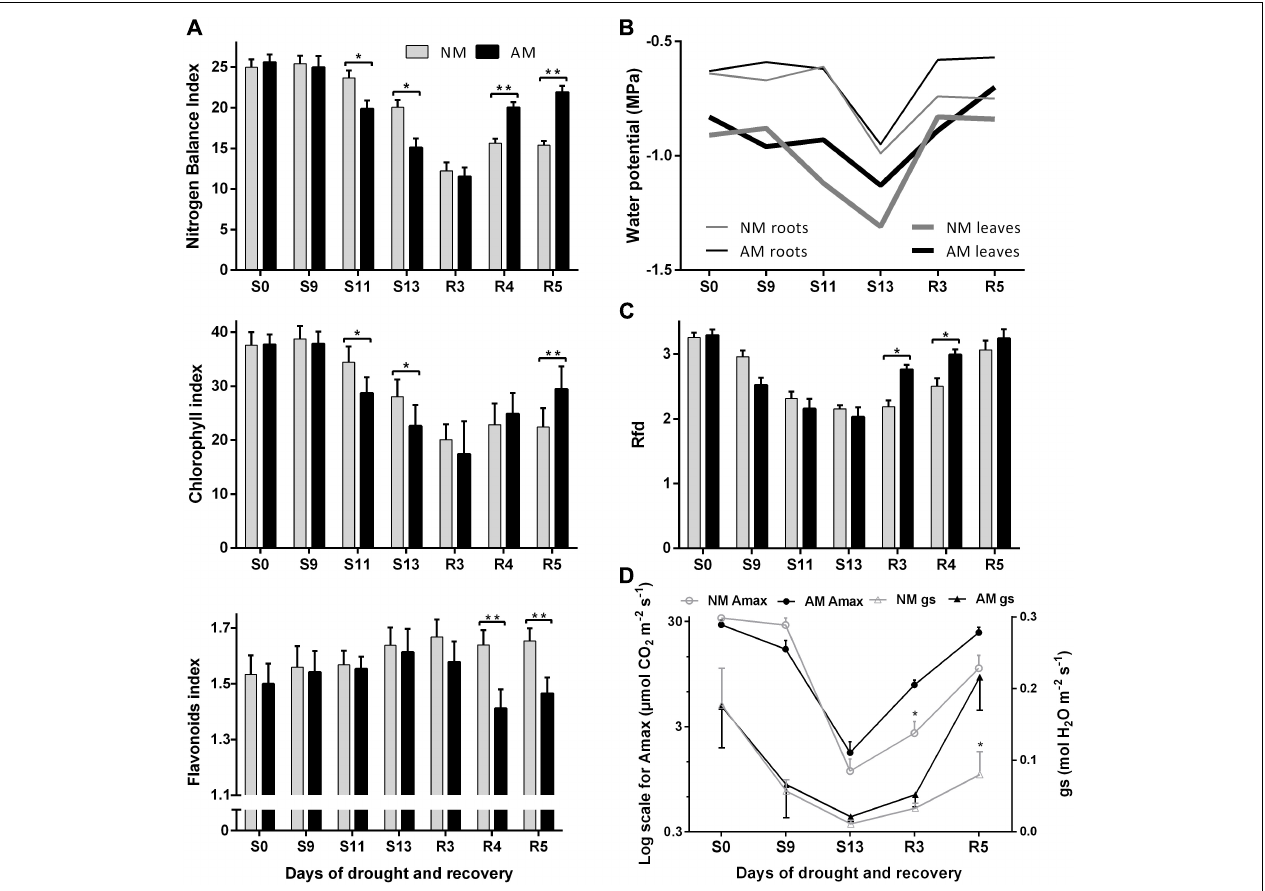
FIGURE 5 | Effect of progressive drought and recovery on leaf nitrogen (A) and water (B) status, PSII quantum conversion (C) and light-saturated photosynthetic efficiency (D) . Rfd, chlorophyll fluorescence decrease ratio; Amax, light-saturated photosynthetic rate; gs, maximum stomatal conductance to H 2 O. Non-mycorrhized (NM) and mycorrhized (AM) plants were evaluated during full hydration (S0), drought conditions (S9, S11, S13) and rehydration (R3, R4, R5). The bars represent average values taken from combined measurements from the middle leaves (L4 + 5, ear leaf and leaf above); n = 100 for NBI, Chl and Flv: 5 plants × 2 leaves × 10 sampling points covering upper half of leaf length; n = 8 for Rfd, Amax, gs: 4 plants × 2 leaves. Asterisks show statistically significant difference between NM and NM means according to t -Student test ( ∗ p < 0.05, ∗∗ p < 0.01, ∗∗∗ p <